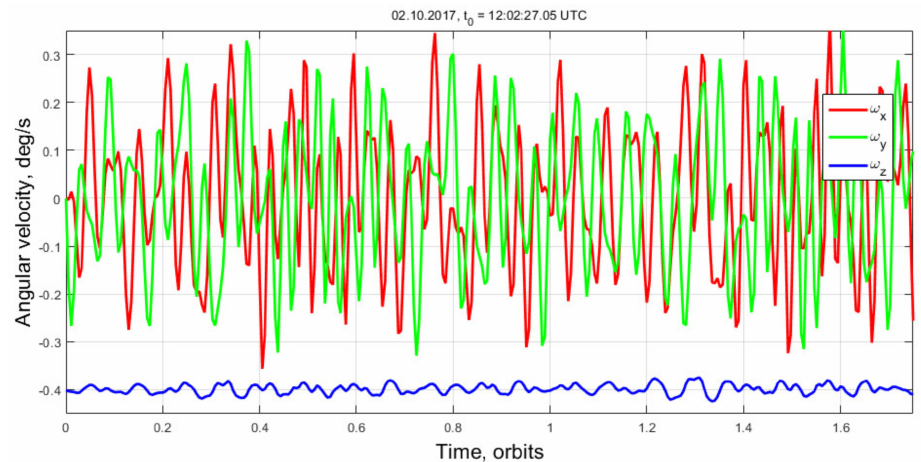
Figure 10. Angular velocity in the steady-state motion.